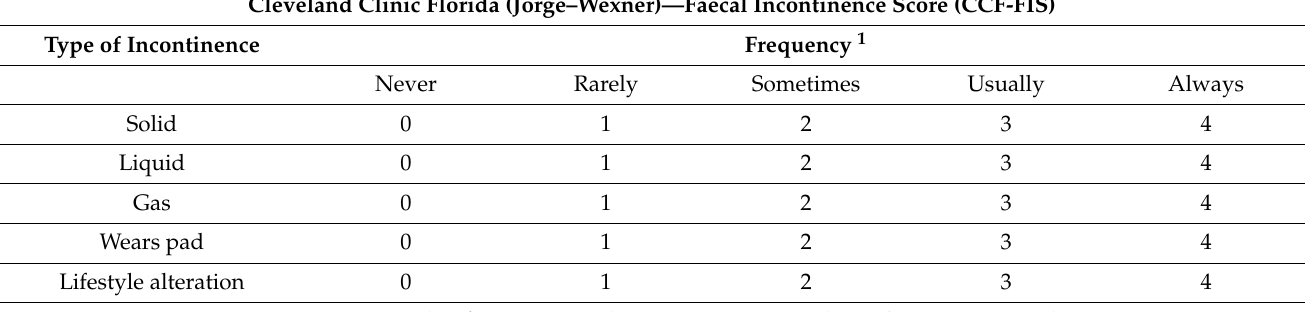
Table 2. Comparison between the available diagnostic tools for the assessment of